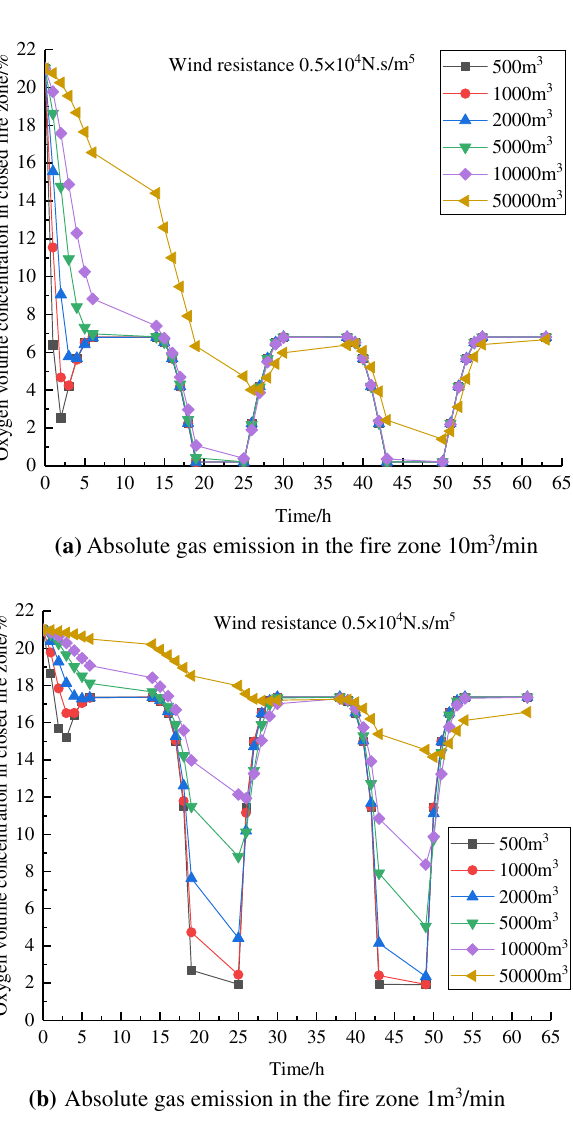
Fig. 5 Gas emission, fire zone volume and wind resistance are small. The relationship between oxygen concentration and time in the fire zone after the completion of sealing at 19:00 in the evening is